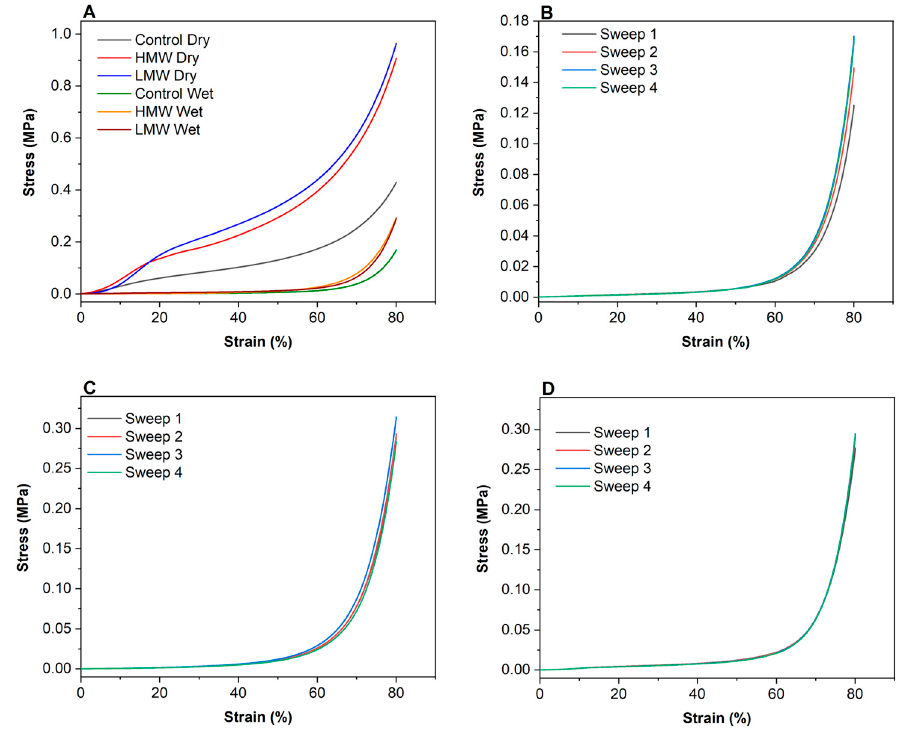
Figure 6. Compression stress–strain curves for ( A ) dry scaffolds, ( B ) hydrated control scaffolds, ( C ) hydrated collagen scaffolds with HMW chitosan, and ( D ) hydrated collagen scaffolds with LMW chitosan.